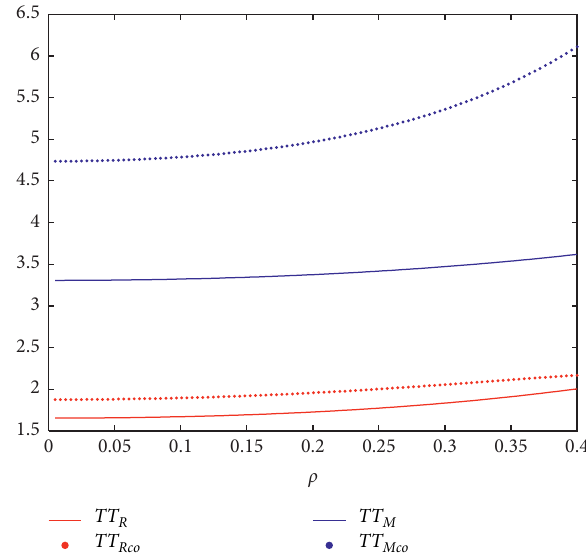
Figure 5: Profit comparison between decentralized and centralized decisions when ρ